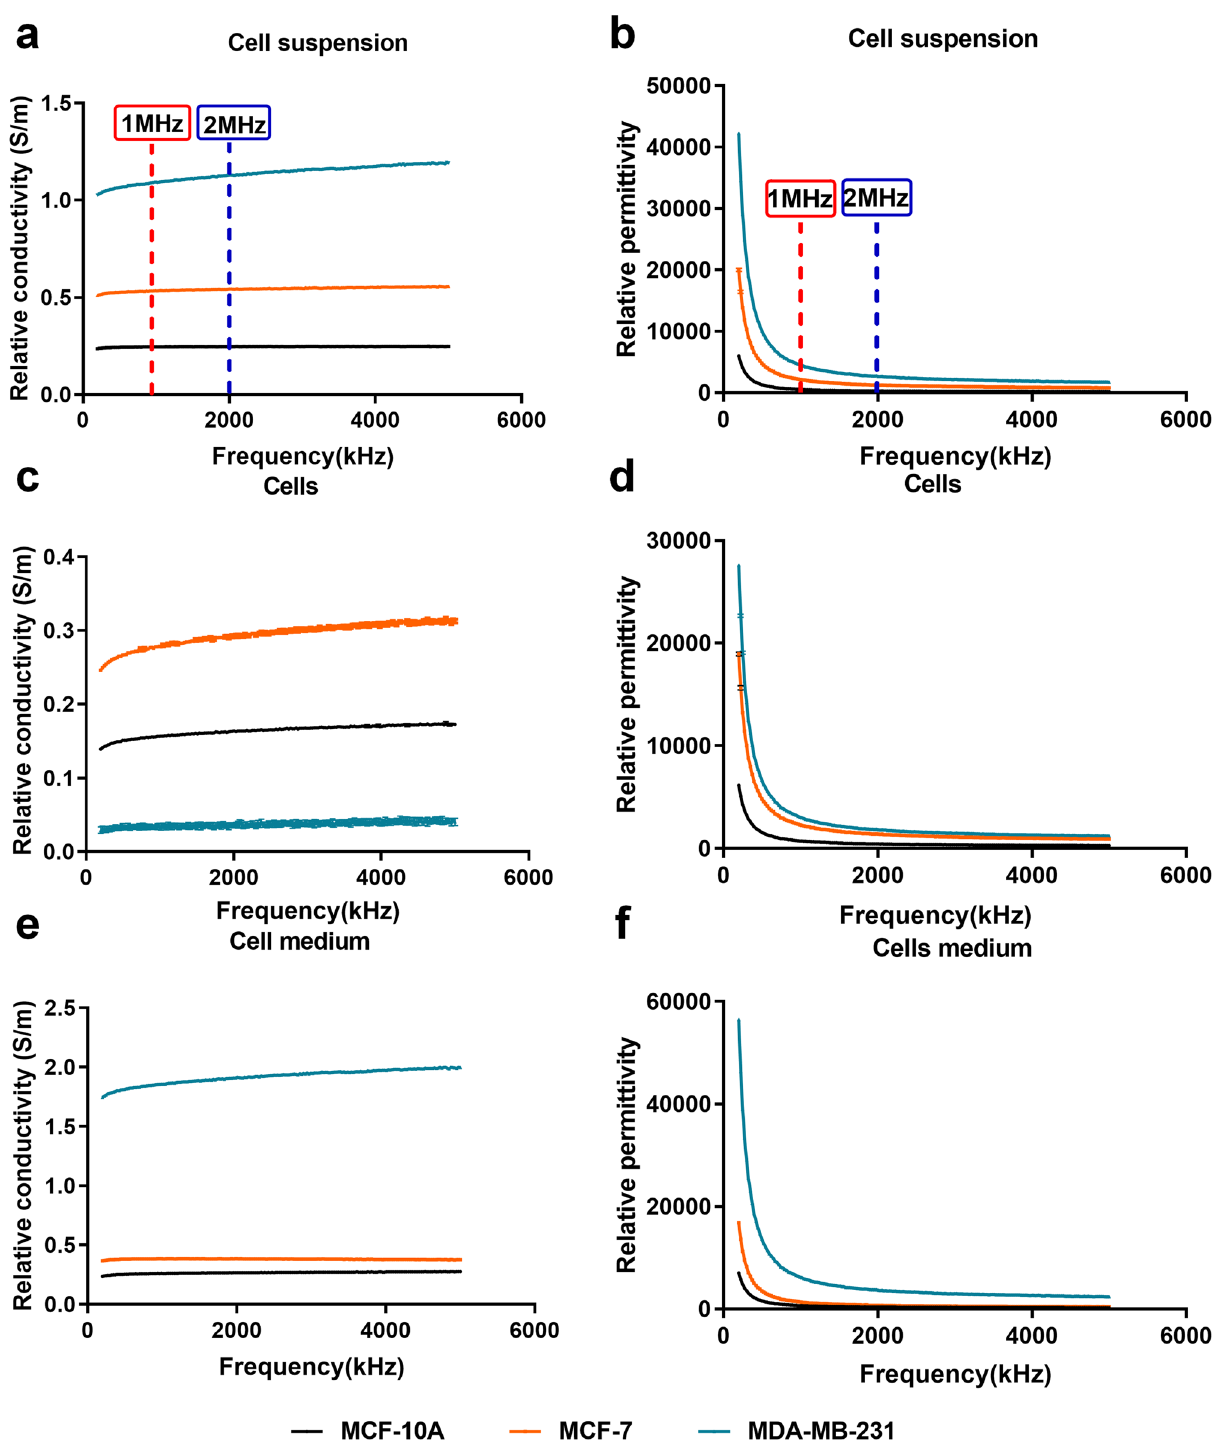
Figure 1. σ and ε of normal glandular mammary epithelial cell MCF-10A, breast cancer cell MCF-7, and MDA-MB-231 in the frequency range 200 kHz–5 MHz. Variation trend of σ and ε in cell suspensions group ( a , b ), cells group ( c , d ) and cell medium group ( e , f ). (Data are means ± SD, n =